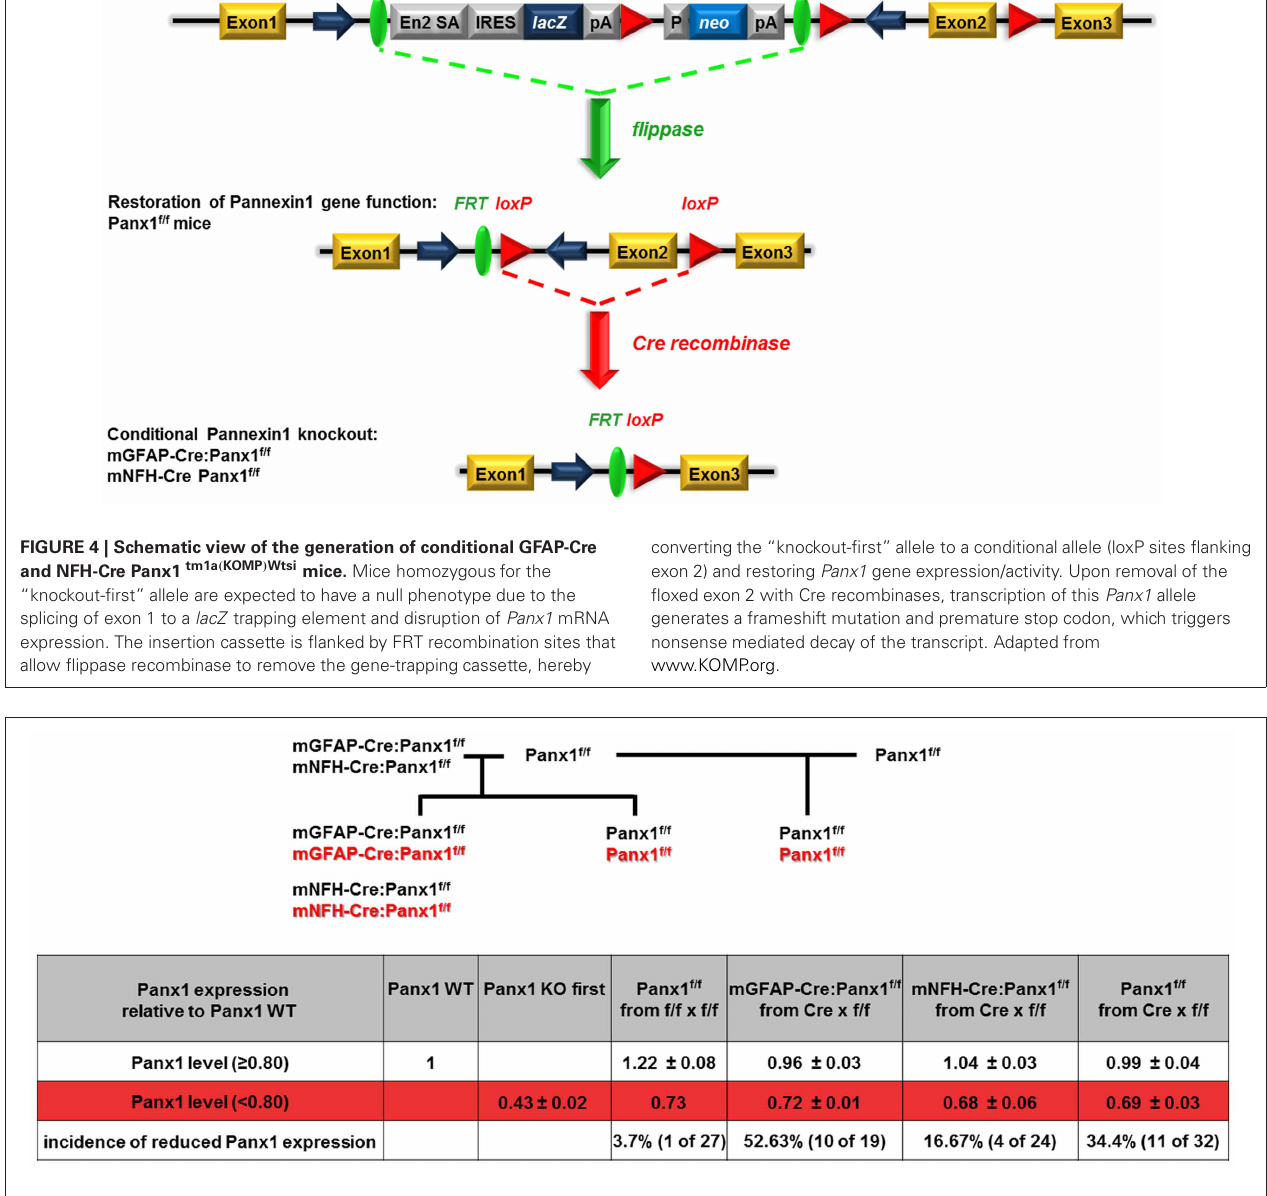
FIGURE 5 | Ectopic activity of Cre recombinase. (Top) Breeding scheme of Panx1 f / f mice and conditional Panx1 knockout mice (mGFAP-Cre:Panx1 f / f and NFH-Cre-Panx1 f / f ) used to evaluate Panx1 mRNA expression. (Bottom) Table showing Panx1 expression determined by tail qPCR of